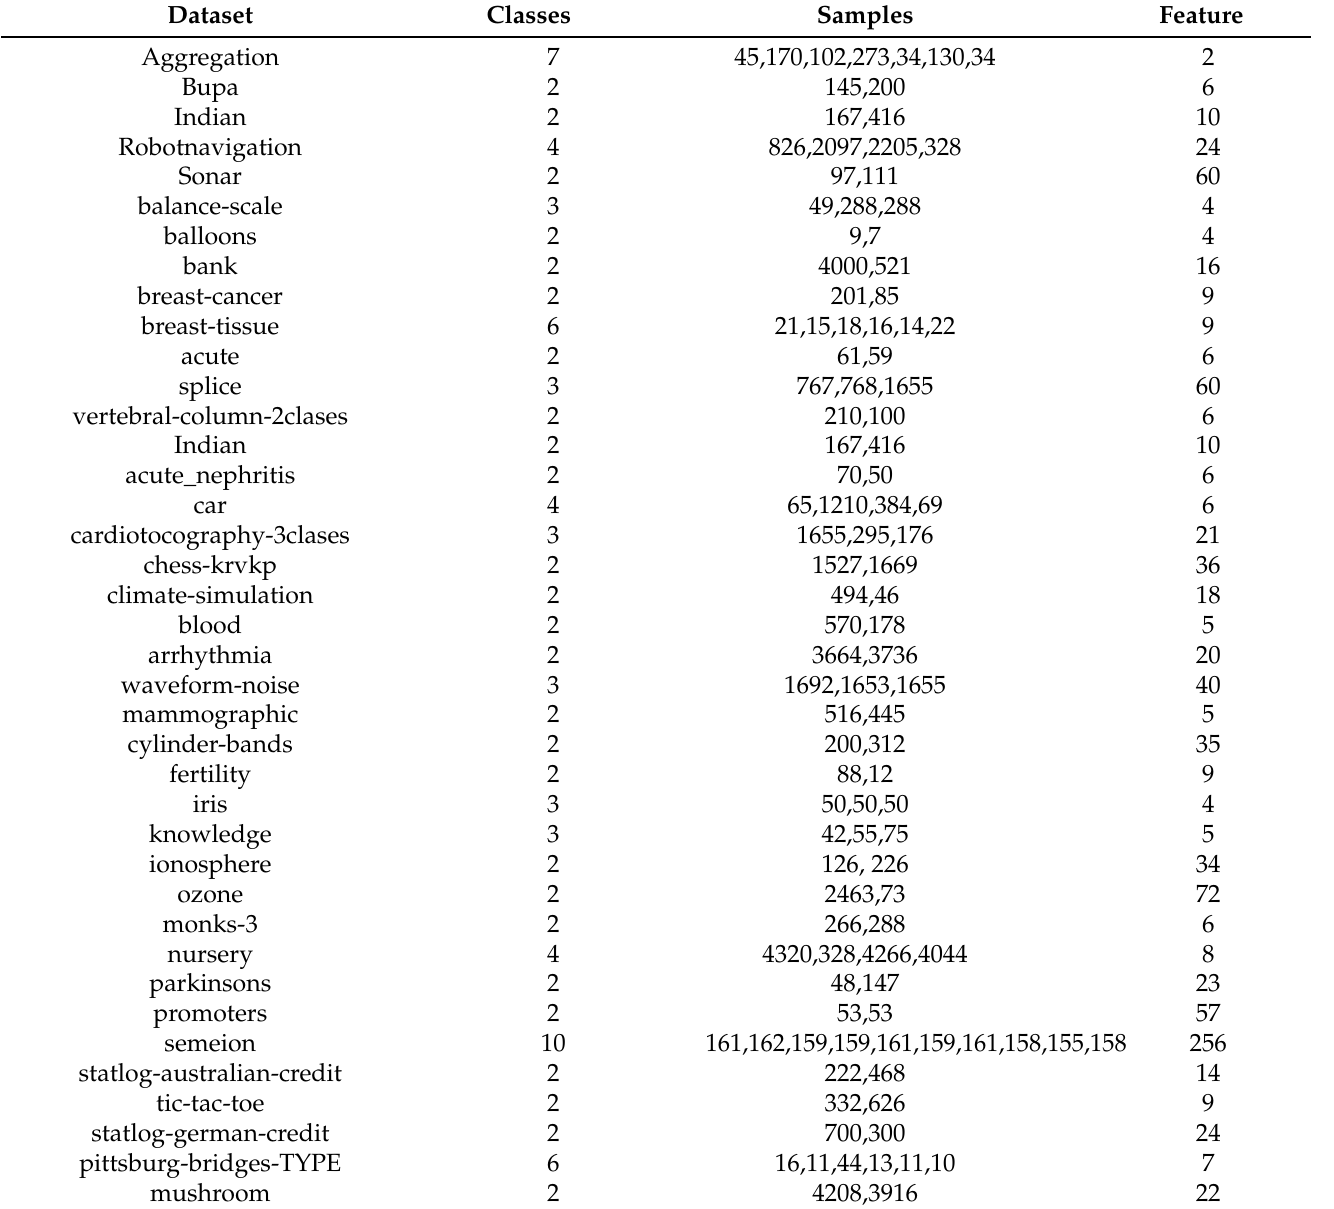
Table 6. The details of UCI benchmark